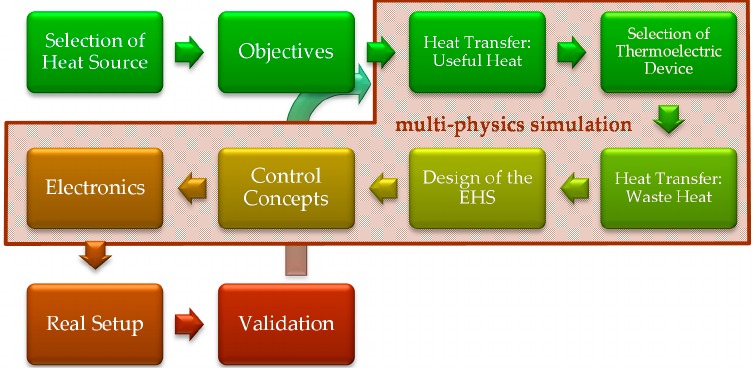
Figure 4. Model-based development process for thermoelectric energy harvesting systems [23].